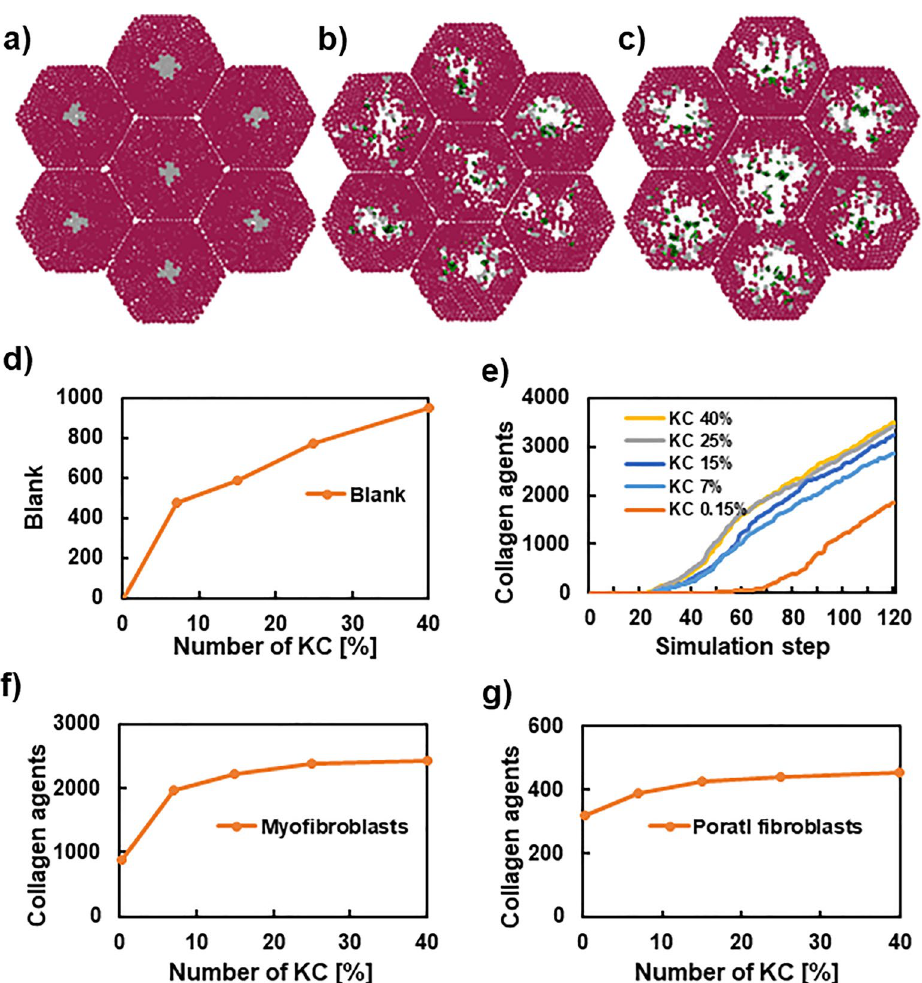
Figure 6. The comparison of simulated results with different initial KC cells. The 2-dimensional tissue sections at step 40 ( a – c ). Hepatocytes (brown), dead cells (grey), and collagens secreted from myofibroblasts and portal fibroblasts (blue and green). The initial conditions before simulation are depicted in Fig. S2. Panel ( d ) shows the relationship between the initial number of KC and blank areas. Panel ( e ) shows the time-course of collagen agents with various initial KC ratios. Panels ( f ) and ( g ) show the relationship between initial KC ratios and collagen agents produced from myofibroblasts and portal fibroblasts,